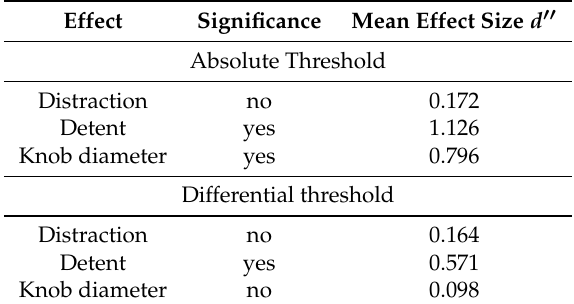
Table 4. Summary of effects and mean effect